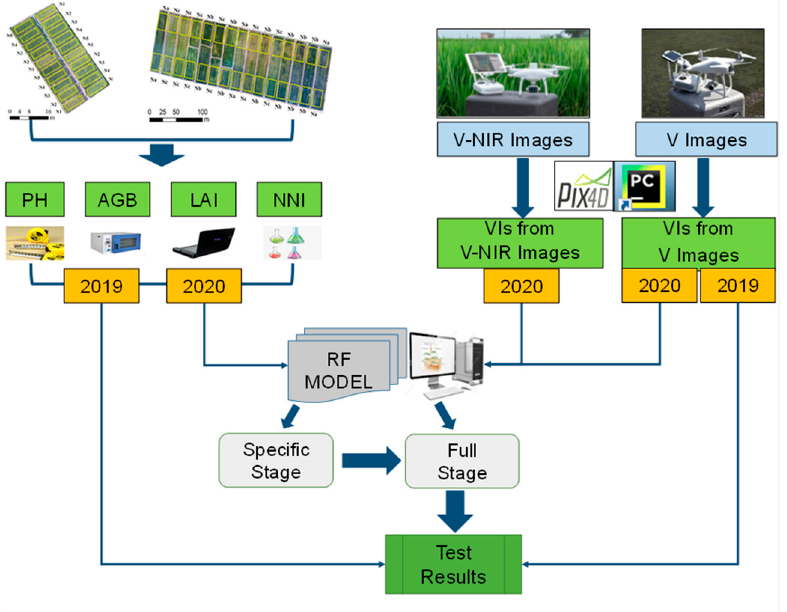
Figure 3. Diagram of the method overview in this study. (PH, rice plant height; LAI, leaf area index; AGB, aboveground biomass; NNI, nitrogen nutrient index; VIs, vegetation indices; V, visible; NIR, near infrared; RF, random forest.